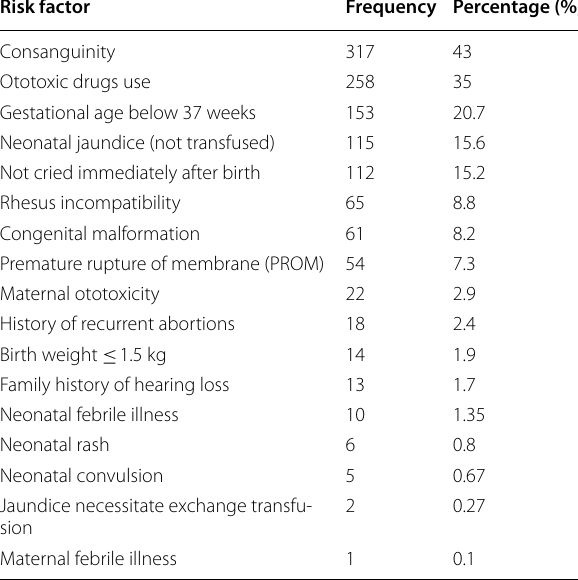
Table 1 Distribution of assumed risk factors for hearing